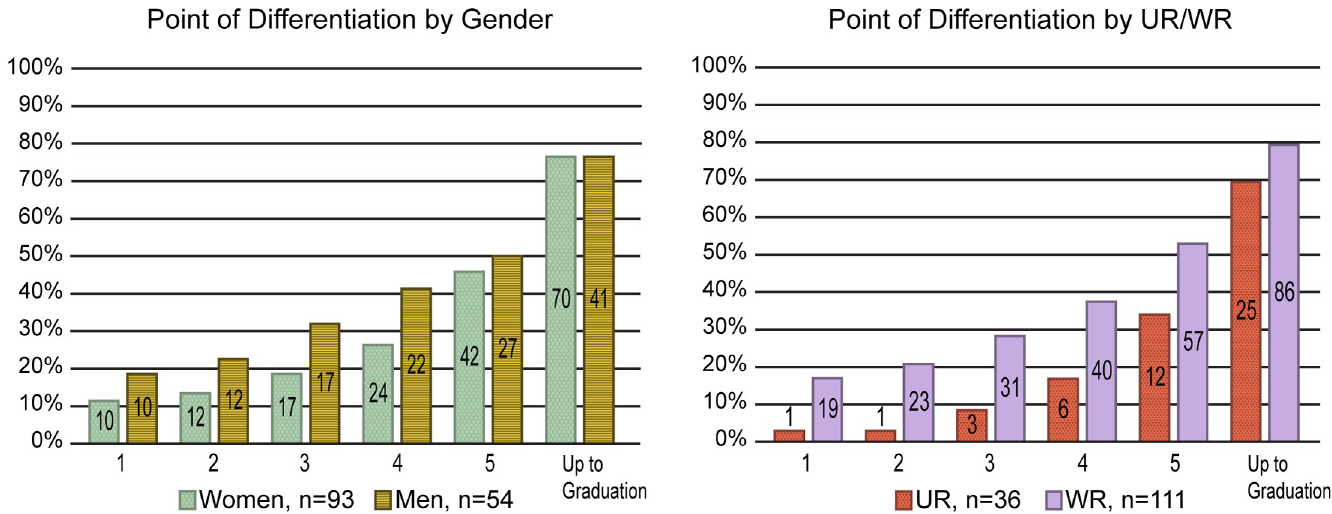
Fig 2. Point of career differentiation during the PhD. The data in Fig 2 represent the “point of differentiation” into a primary career among participants separated by gender and UR/WR status. The point of differentiation is the PhD year at which a participant decided on a career choice, after which they did not waver. The data in the bars are cumulative and display the total number and percentage of participants in each population who differentiated at or before a specified time point. The start of the fifth year of the PhD was the first year in which anyone in the study graduated and is the last real time point reflected. The denotation “up to graduation” captures any differentiation that occurred between the end of the fifth year and graduation. While there were no significant differences (Pearson’s chi-squared test, p < .05) between men and women, a significantly smaller proportion of UR trainees differentiated into a career during the first three years when compared to WR